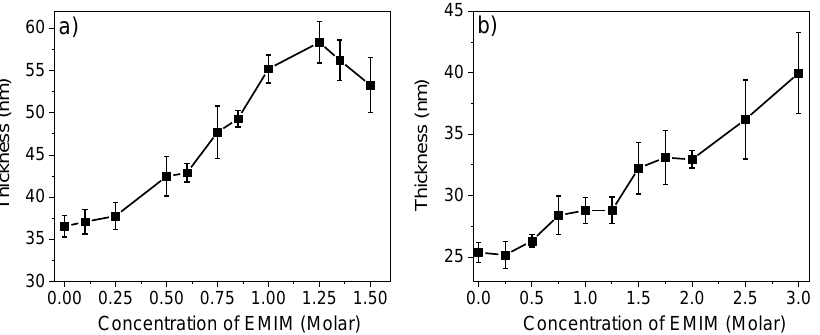
Figure 3. Modeled thickness of the ( a ) PEI(PSS / PDADMAC) 4 PSS and ( b ) PEI(PSS / PAH) 4 PSS multilayers vs. the concentration of EMIM solution used for the multilayer swelling in reversible cycles. The error bar is the standard error obtained from averaging over 3 data sets at the respective EMIM concentration.